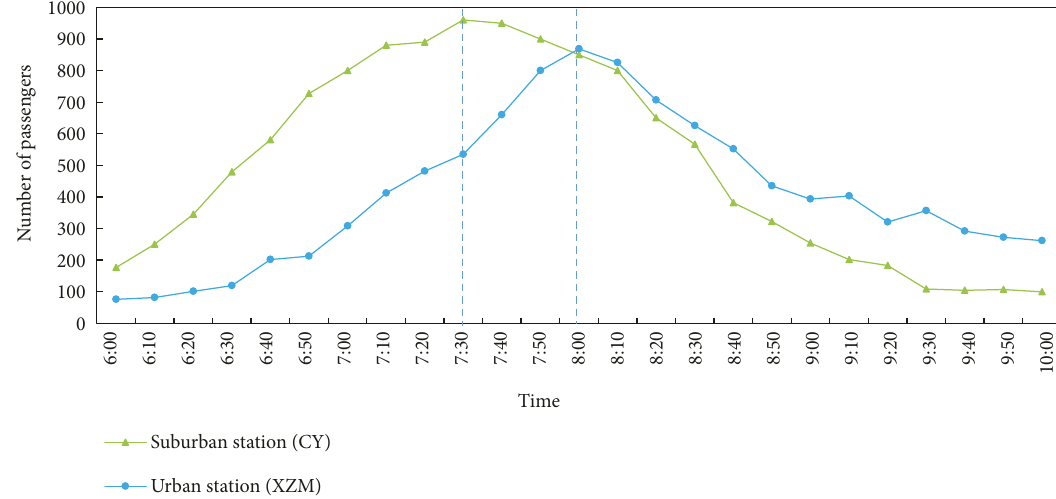
Figure 14: Distribution of station demand of two typical stations.